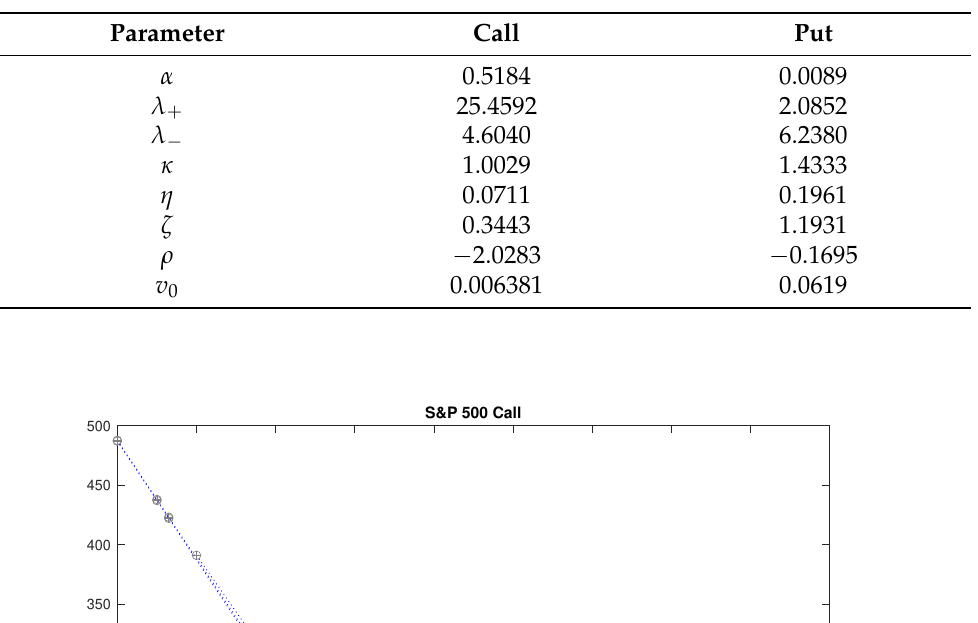
Table 2. Calibrated Parameters for the SPX option on 11 September 2017.